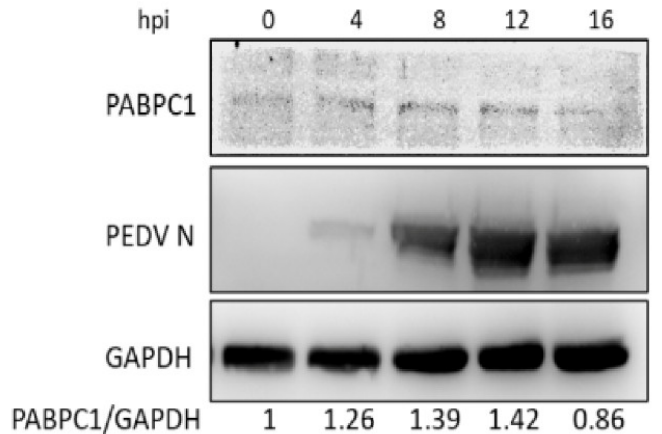
Figure 1. Expression changes in PABPC1 at protein level in Vero cells after PEDV infection. The bottom numbers mean the relative expression folds of PABPC1 protein analyzed by grayscale scanning.